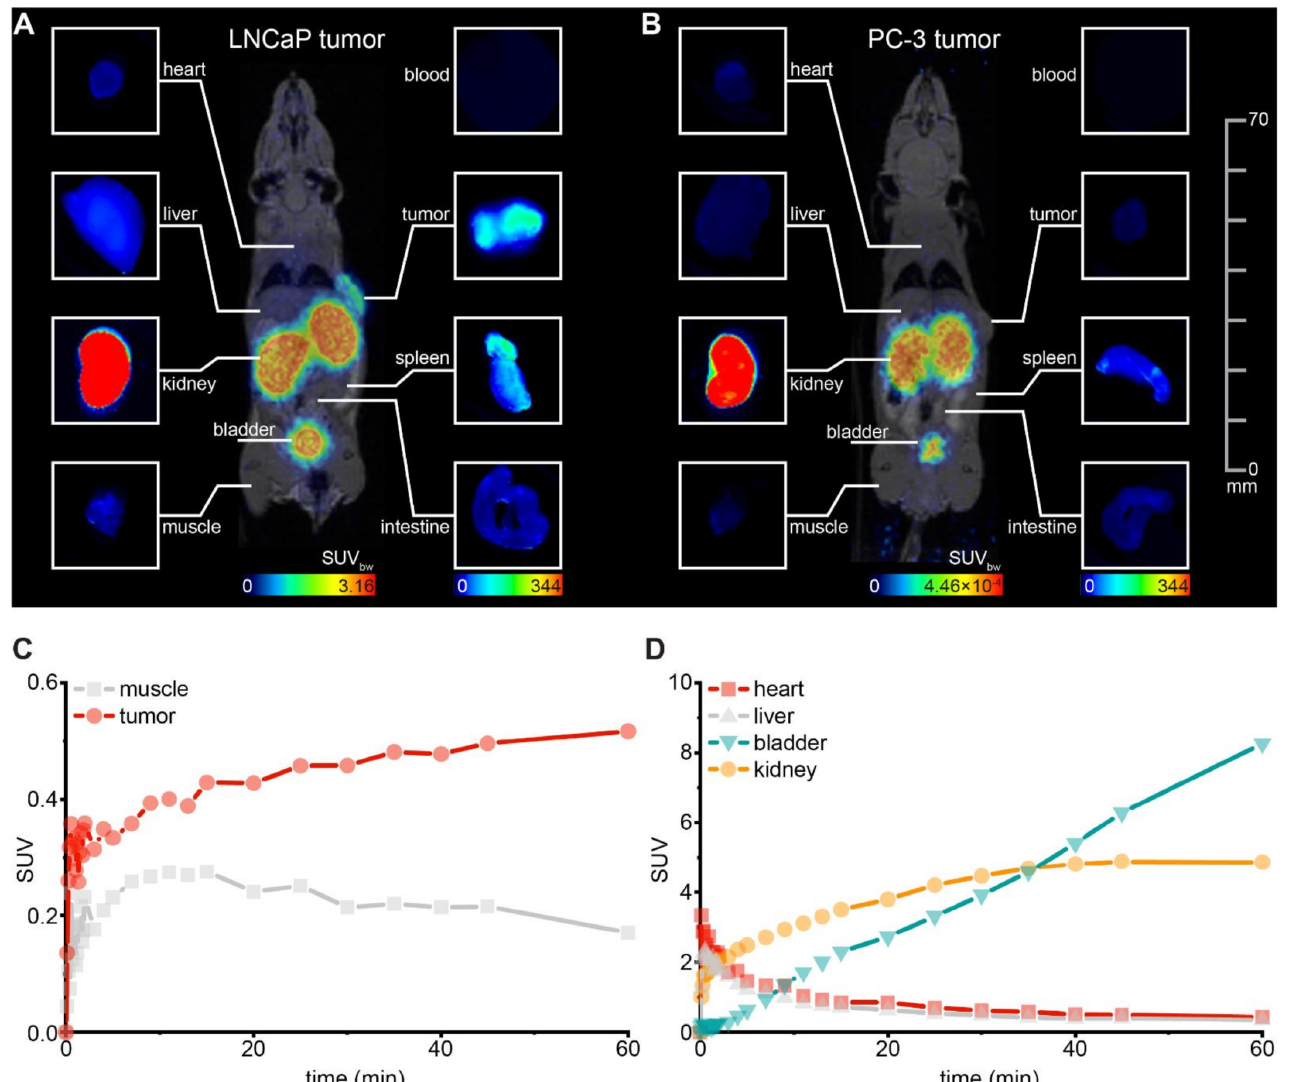
Figure 5. Small-animal proof-of-concept study. Whole-body maximum intensity projections of 0.5 nmol 68 Ga-labeled PSMA-927 in ( A ) LNCaP- and ( B ) PC-3-tumor-bearing BALB/c nu/nu mice (right flank) 120 min p.i. obtained from small-animal PET/MR imaging (each n = 1) and corresponding fluorescence images of organs dissected after PET/MRI (acquired with the Odyssey CLx system; excitation wavelength 800 nm). For the PSMA-positive LNCaP-tumor, corresponding time activity curves are shown ( C ) for tumor and muscle and ( D ) for background organs. SUV = standardized uptake